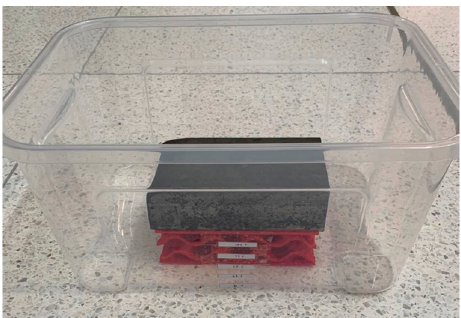
Figure 6. Demonstrating the preparation of test setup for dry and flood conditions.